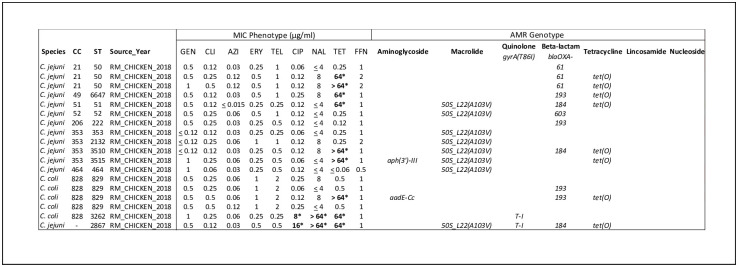
Campylobacter antibiotic susceptibility test results in retail meat aligned with AMR genotype, MLST, and source.Bold (*) = resistant. NARMS FDA C. coli and C. jejuni minimum inhibitory concentration (MIC) results for retail meat in North Carolina compared to isolate MLST and AMR genotype. MIC was determined for the following antibiotics: Gentamicin (GEN), Clindamycin (CLI), Azithromycin (AZI), Erythromycin (ERY), Telithromycin (TEL), Ciprofloxacin (CIP), Nalidixic Acid (NAL), Tetracycline (TET), and Florfenicol (FFN).